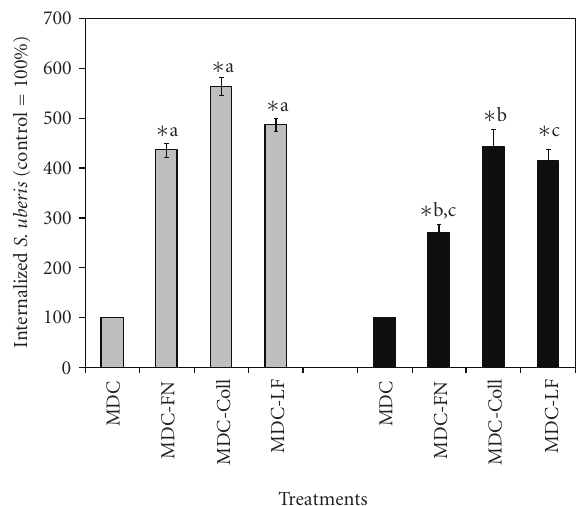
Figure 1: E ff ect of treatment with host proteins on caveloae- mediated internalization of Streptococcus uberis into bovine mam- mary epithelial cells. Fibronectin (FN), collagen (Coll), and bovine lactoferrin (LF), pretreated S. uberis UT888 ( ) and UT366 ( ) were cocultured with bovine mammary epithelial cells treated with the receptor-mediated endocytosis inhibitor monodansyl- cadaverine (MDC) and colony forming units per ml (cfu/mL) of intracellular S. uberis calculated. Data are presented as the percentage of untreated controls (100%; UT888 = 7.9 × 10 4 ; UT366 = 7.0 × 10 3 ) and bars represent the standard error of the mean (SEM) of three independent experiments run in triplicate. ( ∗ ) indicates statistically significant di ff erences ( P < . 05) with the corresponding control. Means with similar superscript letters within each strain are statistically di ff erent ( P < . 05).